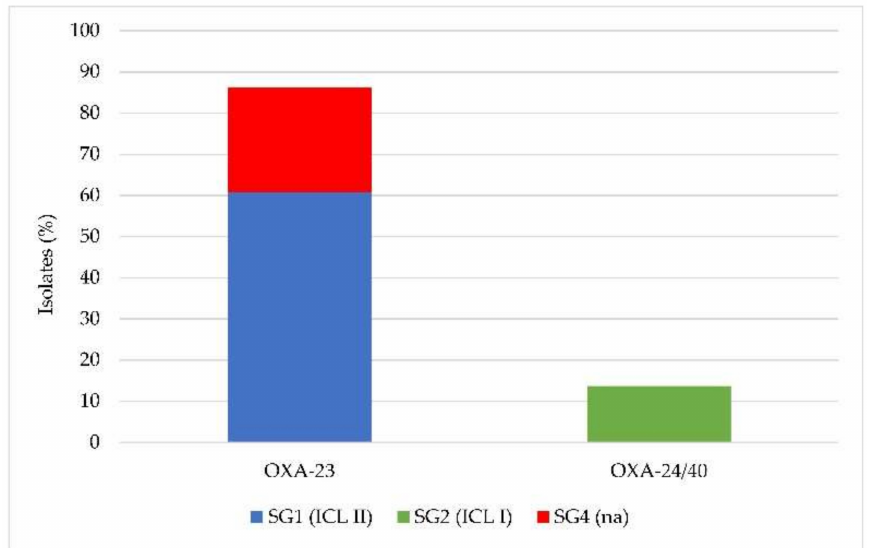
Figure 1. Presence of the bla OXA-23 or bla OXA-24/40 genes in the Acinetobacter baumannii isolates in relation to clonal lineage (na, international clones (ICL) not